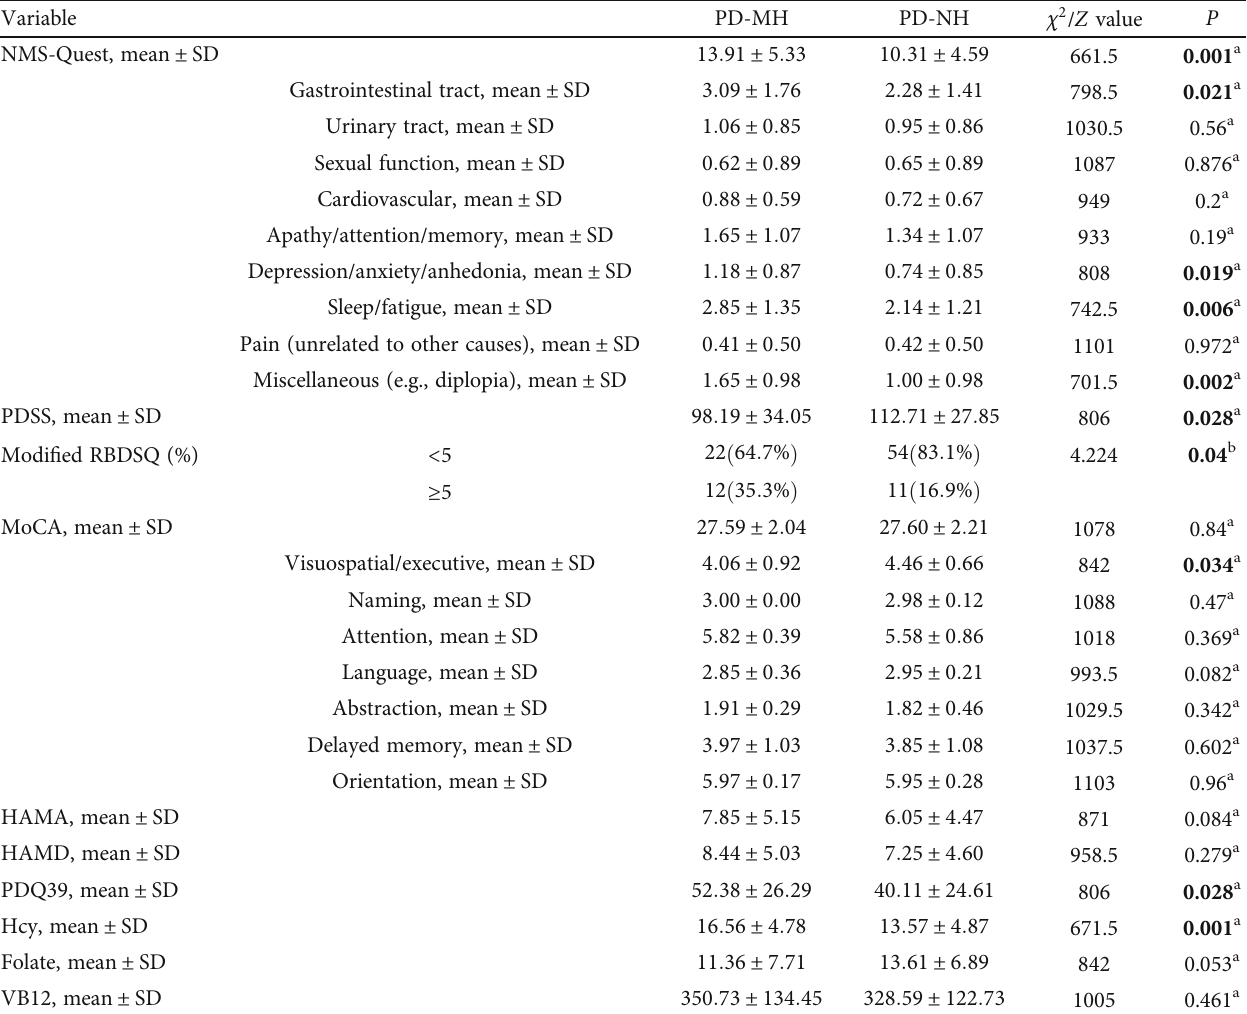
Table 2: Clinical characteristics of the PD-MH and PD-NH patients.